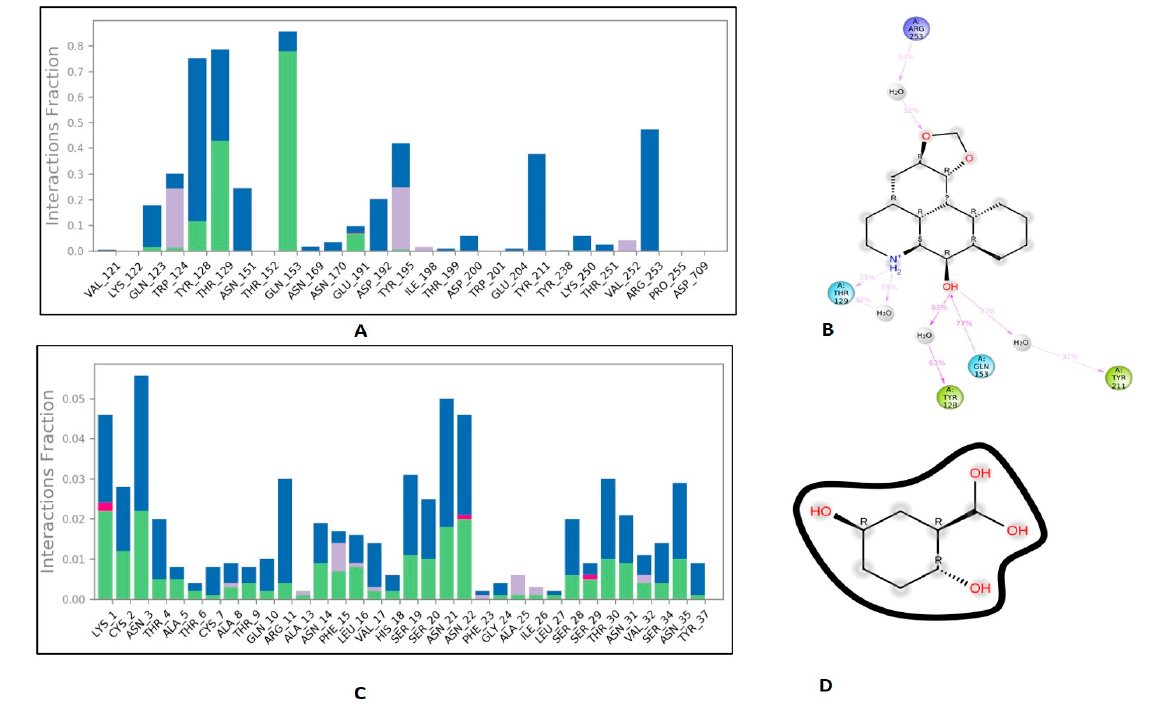
Figure 6. Important protein-ligand interaction residues:( A , B ) PL contact for DPP-4–michelalbine complex; ( C , D ) PL contact for amylin–gentisic acid complex.